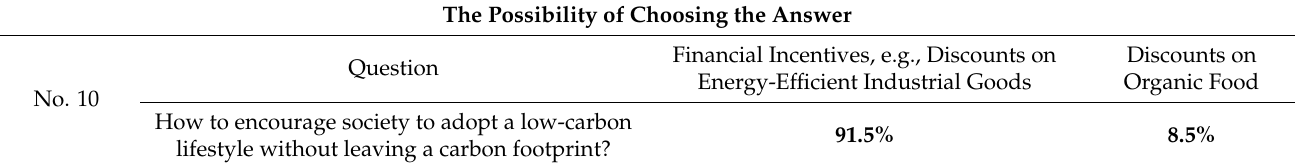
Table 10. Question no. 10, research results.